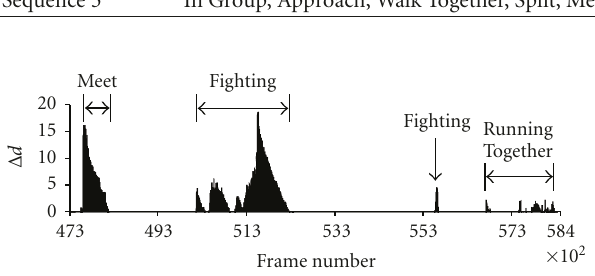
Figure 11: Excessive distances Δ d of the four abnormal events in Sequence 5 of the BEHAVE dataset.